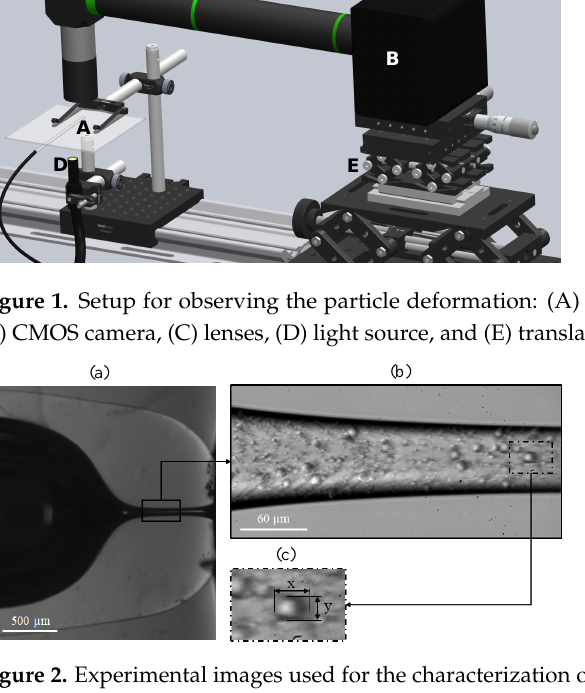
Figure 2. Experimental images used for the characterization of the nozzle shape ( a ), and to evaluate the particles deformation ( b ). Panel ( c ) shows the measurement region for the neck section, and the dimensions of the particle used in the deformation